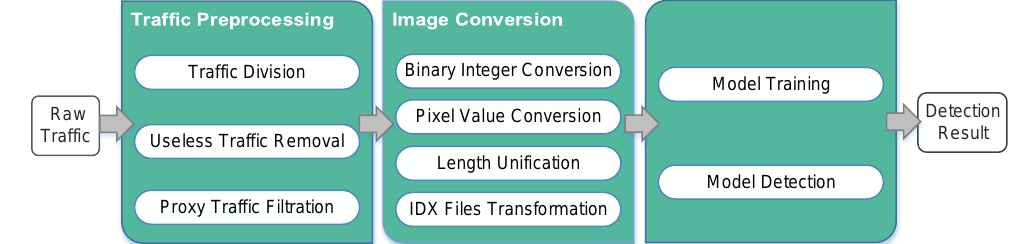
Figure 1. The framework of the